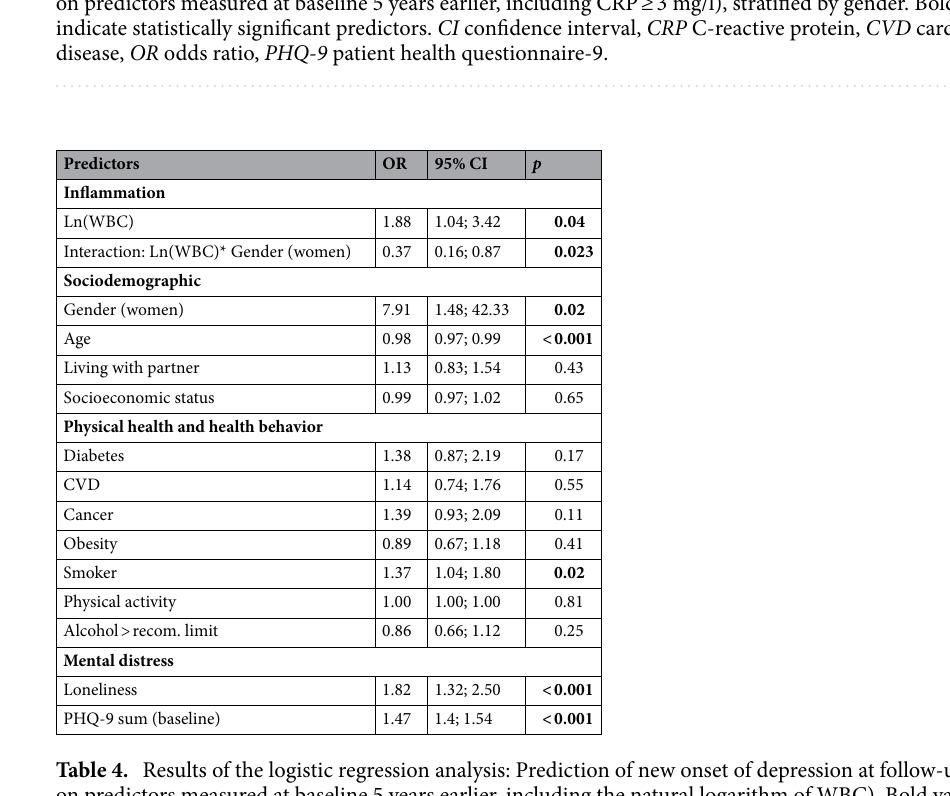
women, lower age, a history of cancer, lower alcohol consumption, loneliness and baseline depression symptoms were predictive of depression, but not CRP. White blood cell count. Table 4 presents the association of baseline ln(WBC) with depression at follow-up. As Table 4 shows, ln(WBC) was predictive of depression (OR 1.88, 95% CI 1.04–3.42) in the total sample. Again, the interaction of the inflammation parameter with gender (OR 0.37, 95% CI 0.16–0.87) indicated a